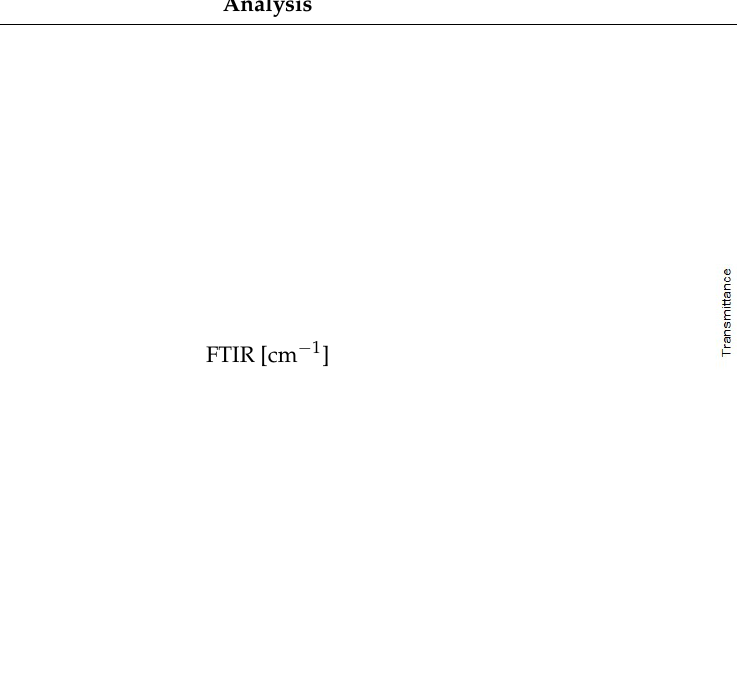
Table 1. Main physicochemical properties of CR232-G5K NPs.